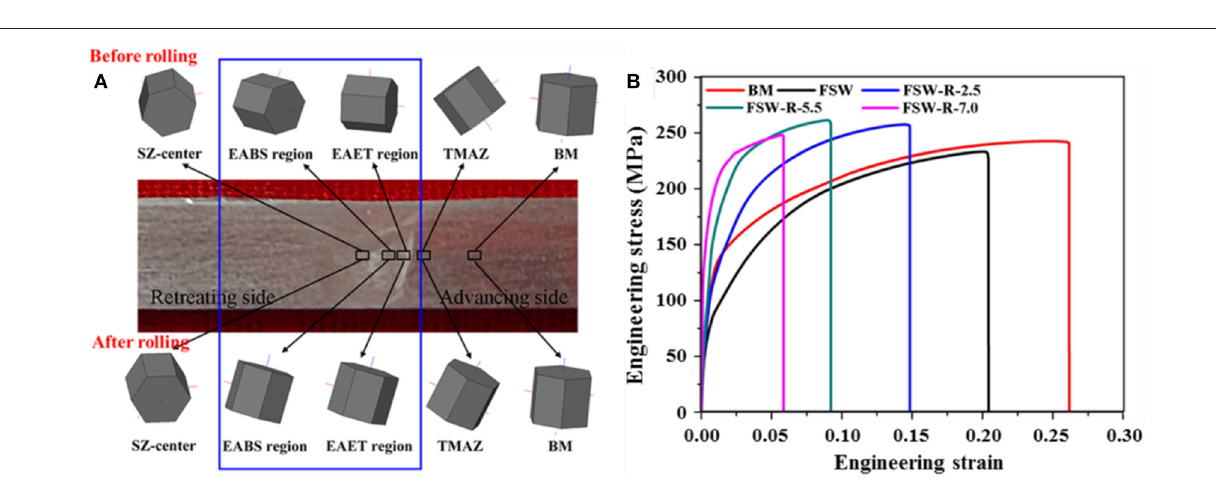
Frontiers in Materials |